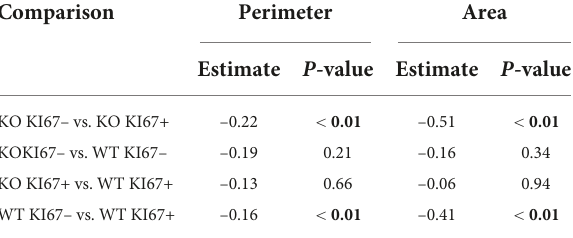
TABLE 2 Coefficient estimates from generalized linear mixed models that tested differences in cell perimeters and areas between genotype × KI67 combinations.